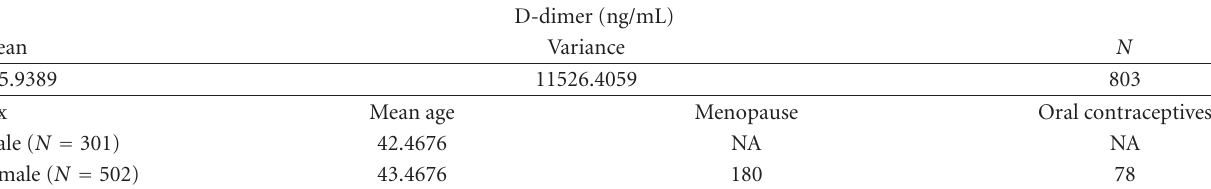
Table 2: Descriptive statistics for D-dimer levels and principal covariates.